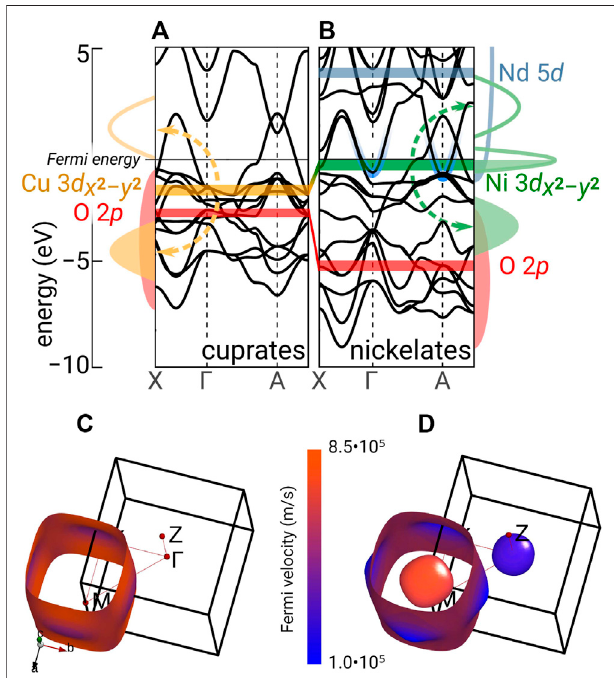
FIGURE 2 | Electronic structures of CaCuO 2 (A) and NdNiO 2 (B) exemplifying superconducting cuprates and nickelates. Top: The bars indicate the center of energy for the most important DFT bands. The dashed arrows indicate the correlation-induced splitting of the Cu or Ni 3 d x 2 − y 2 band into Hubbard bands, leading to the (schematic) spectral function at the side. Cuprates are charge-transfer insulators with a gap between the O 2 p and the upper Cu 3 d x 2 − y 2 Hubbard band as the lower Cu 3 d x 2 − y 2 Hubbard band is below the O 2 p band. For nickelates, bands with a large La (Nd) 5 d contributioncrosstheFermienergyat Γ and A ,self-dopingtheNi3 d x 2 − y 2 band away from half- fi lling. (C,D) : Corresponding DFT Fermi surface. For cuprates, DFT shows a single Cu 3 d x 2 − y 2 hole – like Fermi surface; for nickelates, there is a similar, slightly more warped Ni 3 d x 2 − y 2 Fermi surface and additional small pockets around the Γ and A